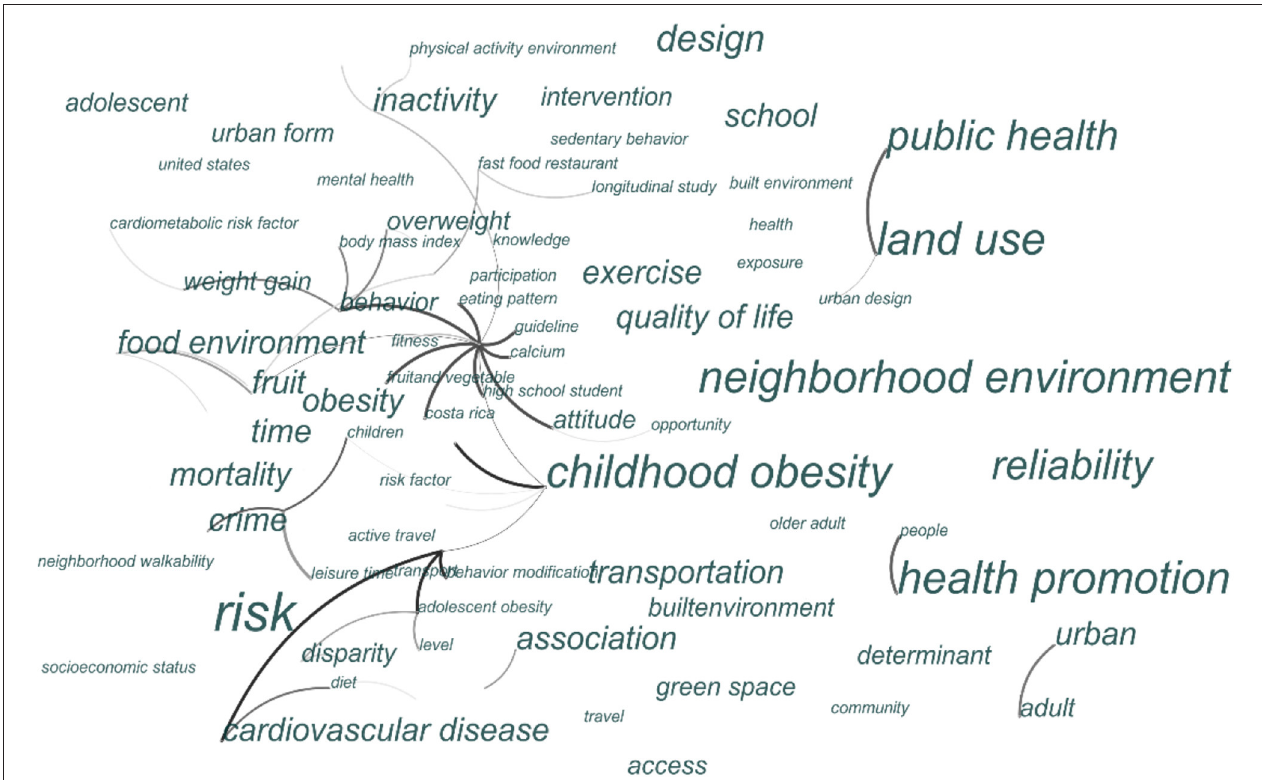
FIGURE 2 | Cluster diagram of key issues related to the built environments and